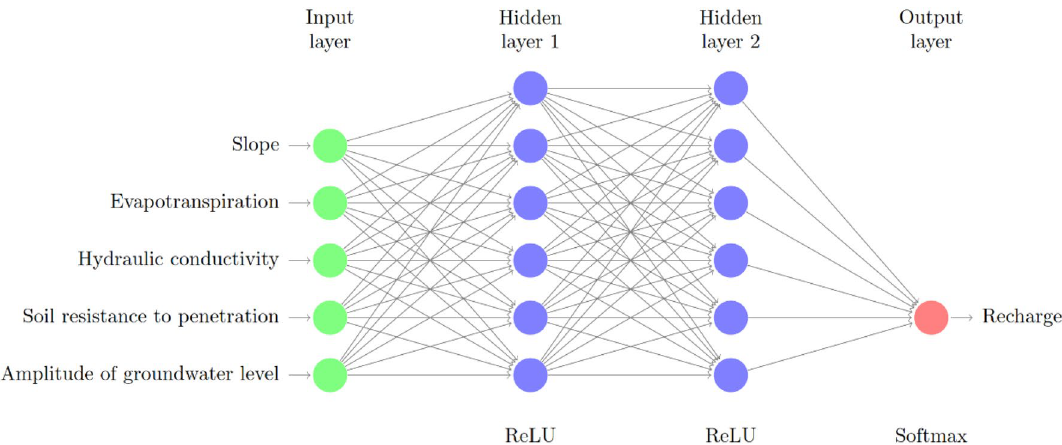
Fig. 6 Artificial neural network